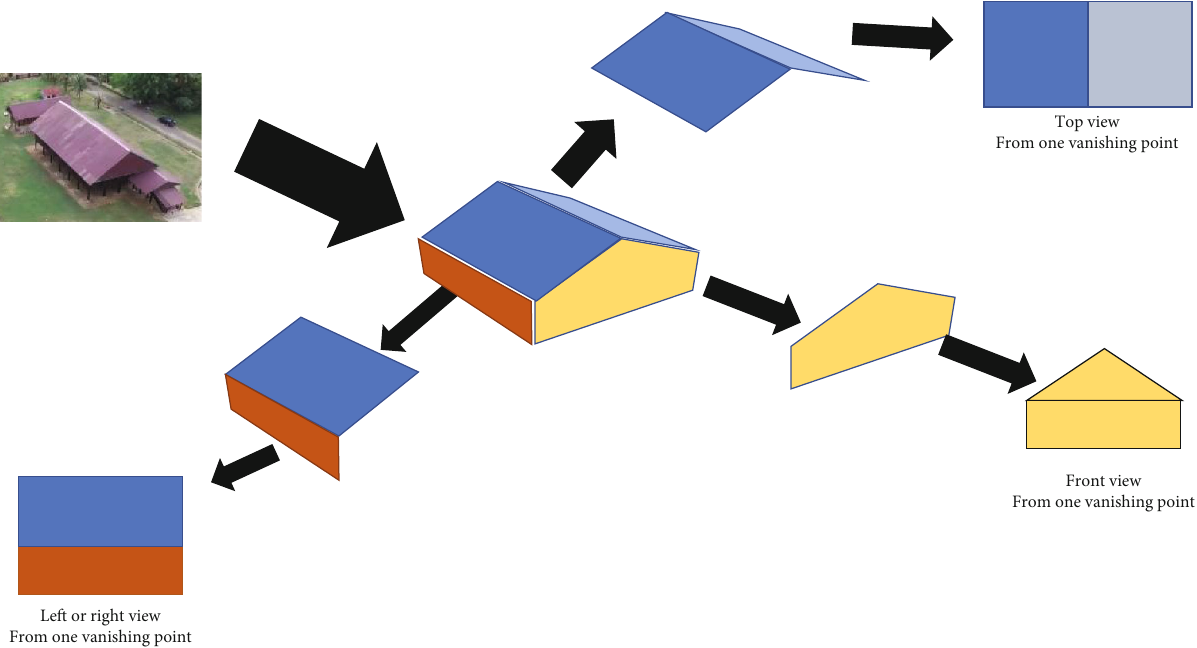
Figure 27: House diagram ’ s parts.